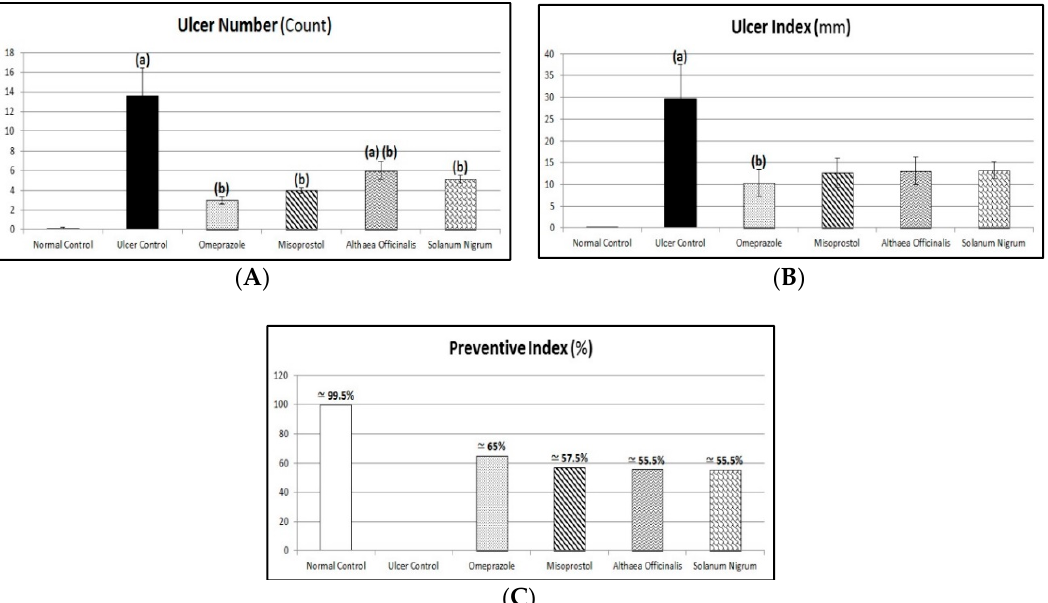
Figure 3. Protective effects of Althaea officinalis and Solanum nigrum compared to the standards misoprostol and omeprazole on ulcer number ( A ), ulcer index ( B ), and preventive index ( C ) against